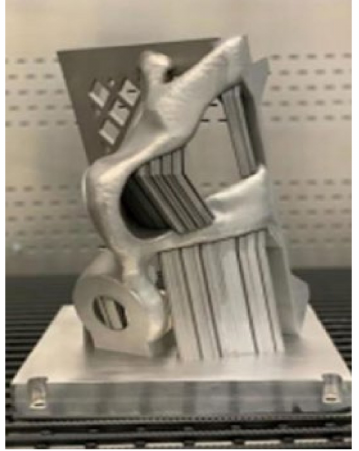
Figure 12. Optimized mount bracket using DFAM [76].